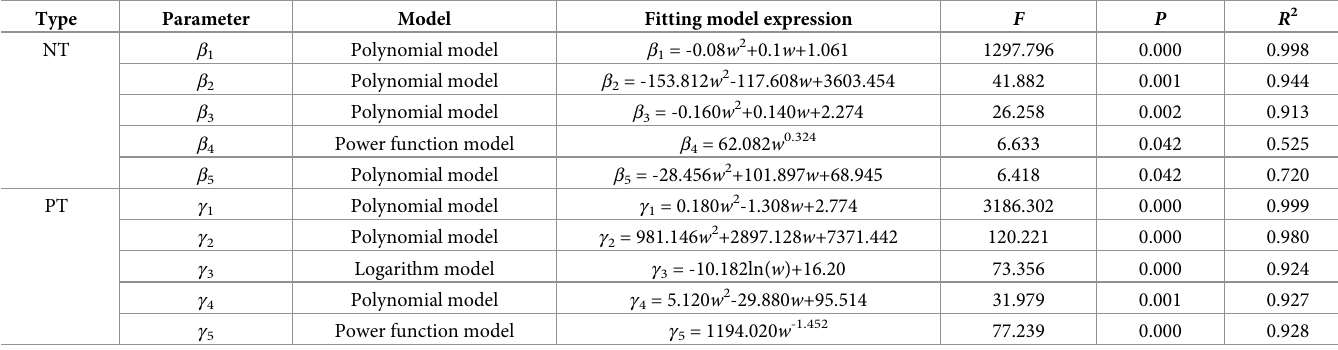
Table 4. Optimal fitting model of relationship between rheological mechanical parameters and moisture content of paddy soil.